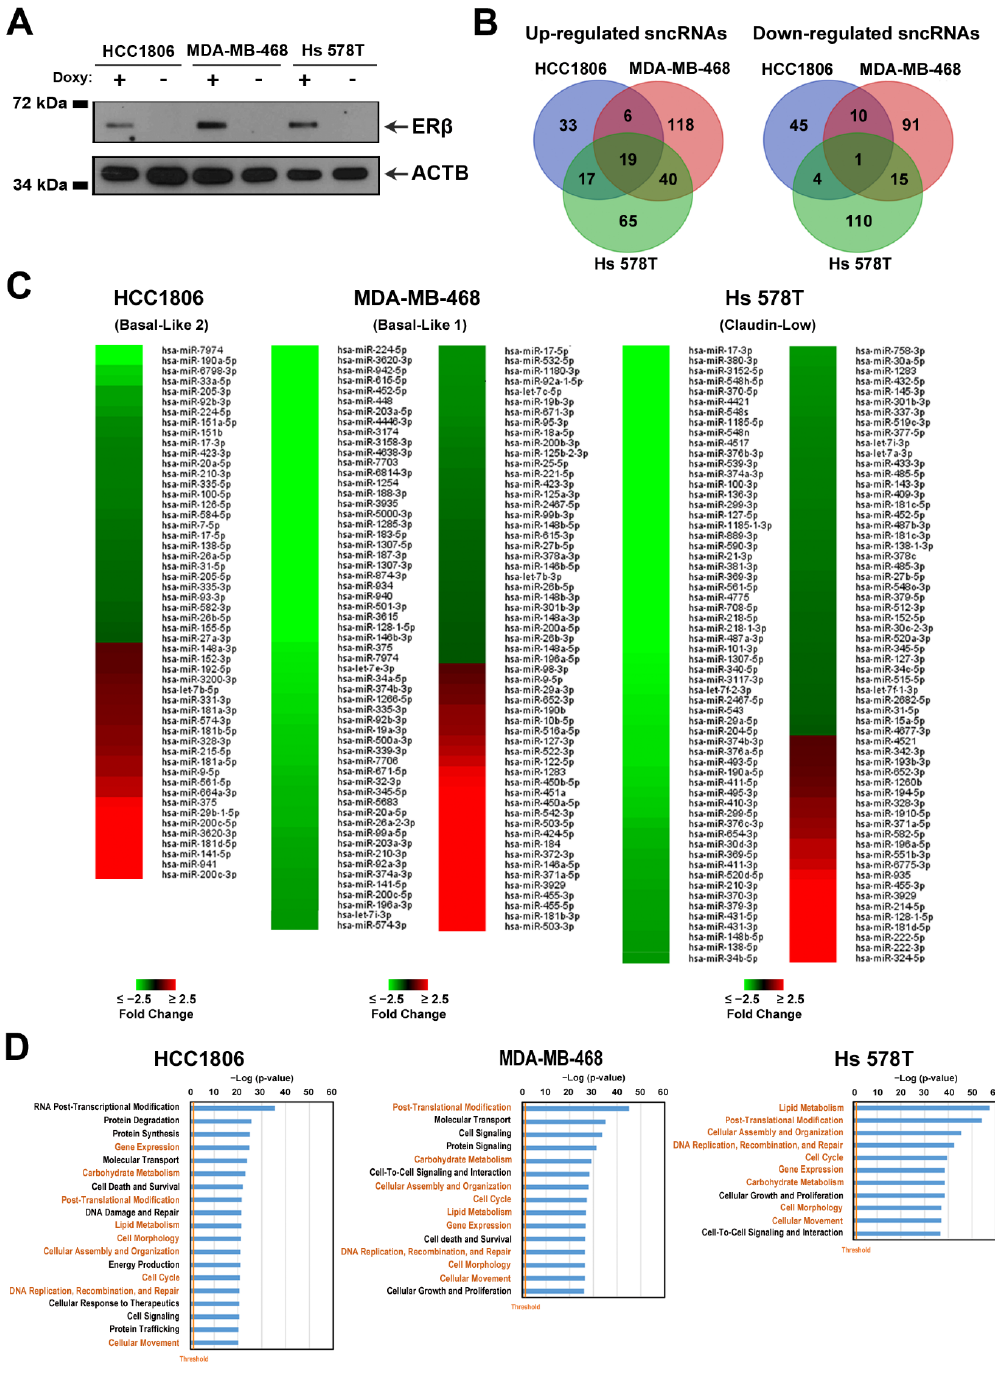
Figure 3. E ff ect of ER β on sncRNA expression profiles and miRNA-regulated functions in TNBC. ( A ) Western blot analysis of ER β expression in the HCC1806, MDA-MB-468, and Hs 578T cell lines upon induction of exogenous receptor expression by doxycycline (Doxy + ) or in its absence (Doxy − ). ( B ) Venn diagram of specific and commonly up-regulated (left panel) or down-regulated (right panel) sncRNAs in ER β -expressing TNBC cells ( | Fold-Change | ( | FC | ) ≥ 1.5, p < 0.05). Only sncRNAs characterized by the same behavior (up- or down-regulated) were included. ( C ) Heatmap showing ER β -regulated miRNAs in the indicated cell lines ( | FC | ≥ 1.5, p < 0.05) ( D ) Ingenuity Pathway Software (IPA) functional annotation analysis performed on ER β -modulated genes predicted to be targets of di ff erentially expressed miRNAs ( | FC | ≥ 1.5, p < 0.05) in the corresponding cell lines. Commonly influenced functions in the three cell lines are indicated in orange. The vertical orange line indicates the p threshold ( p <